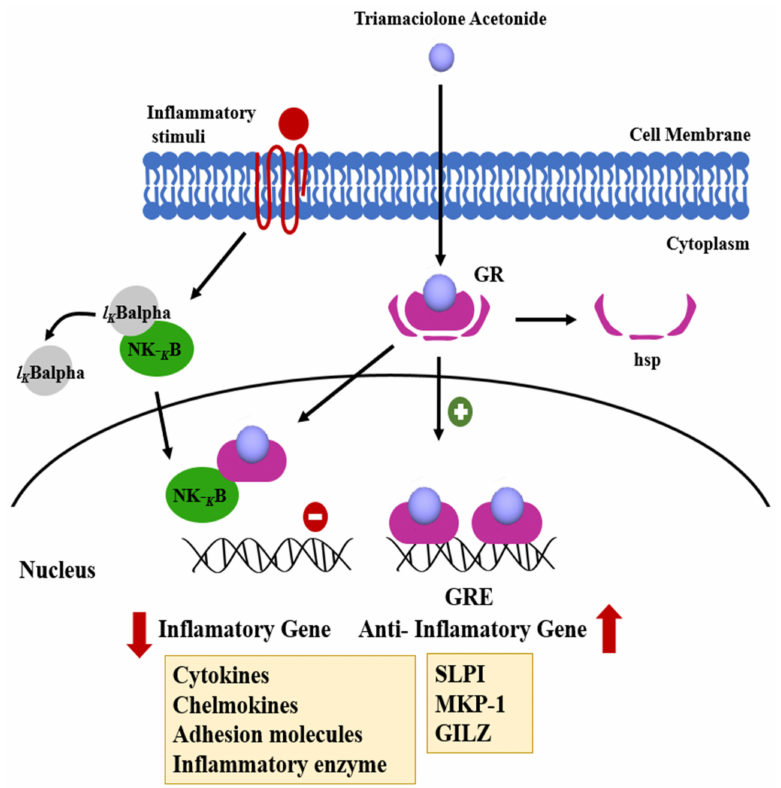
Figure 7. Molecular mechanism of triamcinolone acetonide action. It can reduce the expression of cytokines responsible for capsule formation. Reproduced with permission from